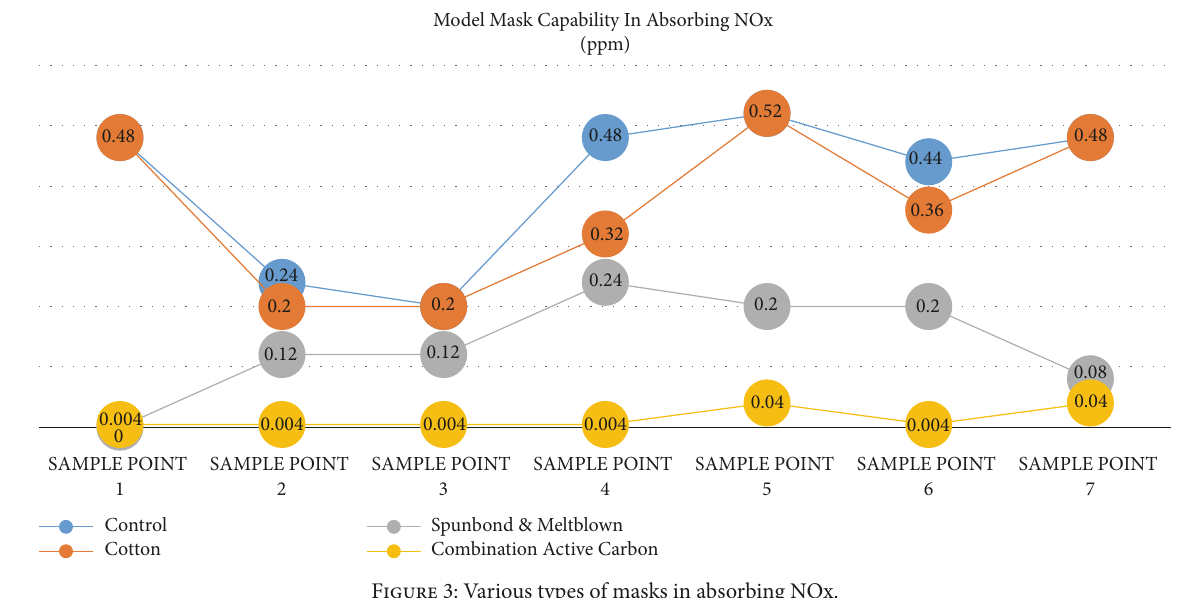
Figure 3: Various types of masks in absorbing NOx. Table 3: Effectiveness of the use of masks and exposure to